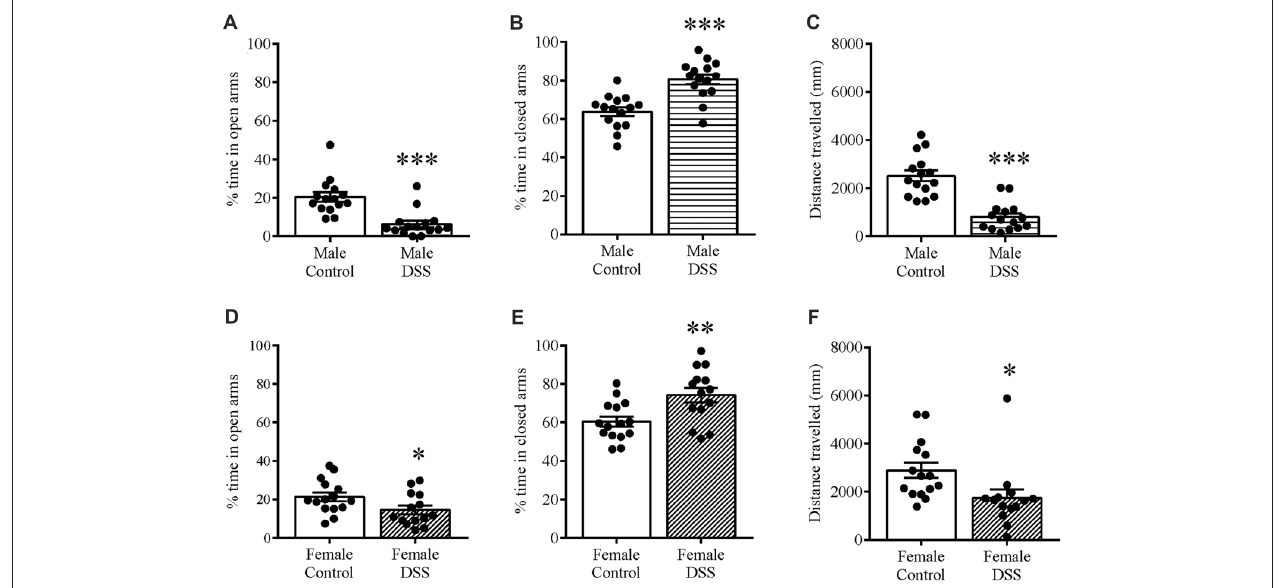
FIGURE 2 | DSS colitis increases anxiety-related behavior and reduces locomotion on the elevated plus-maze (EPM). Male and female control/DSS-treated mice were tested on the EPM on D7. DSS-induced colitis resulted in an anxiety-like phenotype as indicated by reduced percentage time in the unprotected open (A,D) and increased time in the closed arm (B,E) respectively. Reduced locomotor activity is indicated as the reduced total distance traveled in the maze (C,F) in both DSS-treated males and females. ∗∗∗ P < 0.001, ∗∗ P < 0.01, ∗ P < 0.05 vs. control mice.